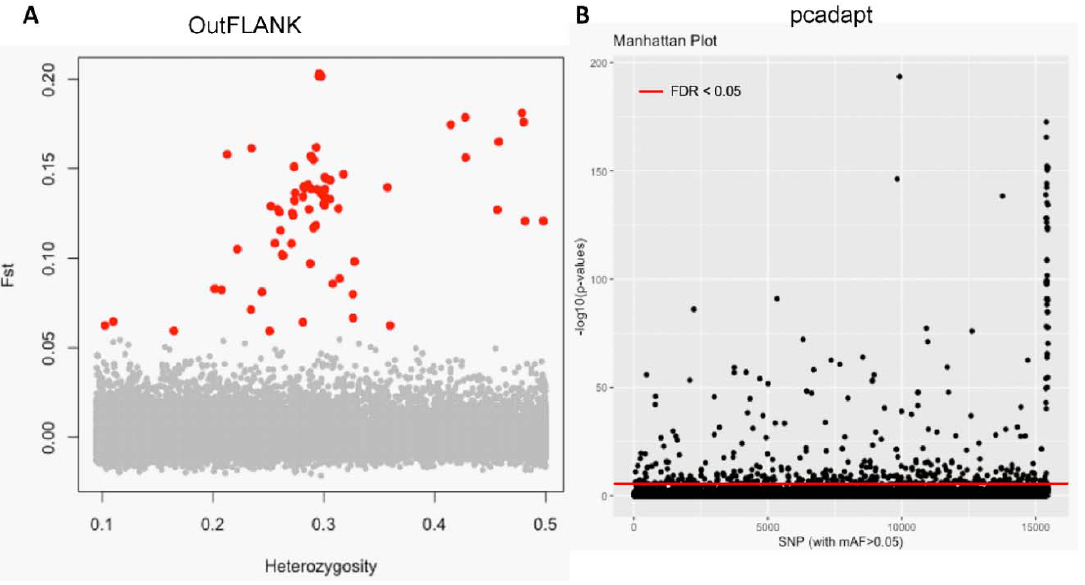
Figure 2. Separation of the putatively adaptive and neutral panels of single nucleotide polymorphisms (SNPs) loci, based on the F ST OutFLANK and pcadapt approaches. Among the 15,453 SNP loci, the F ST OutFLANK approach identified 74 SNPs (red circles) ( A ), whereas the pcadapt approach detected 449 SNPs, as putative adaptive loci (above the red line) ( B ). The remaining were considered to be putatively neutral loci.